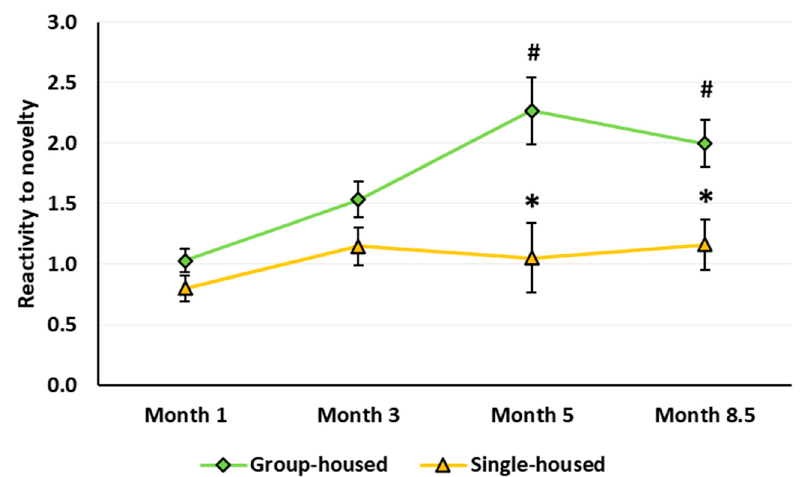
Figure 6. Reactivity to novelty (the ratio of the distance traveled in the first minute to the distance traveled in the fourth minute in the Classic open field test). The * indicates statistically significant difference compared with the group-housed rats of the same age, p < 0.007; the # means p ≤ 0.004 compared with the 1-month-old group-housed rats (ANOVA followed by Newman–Keuls post hoc test). See Supplementary Materials, Table S5.